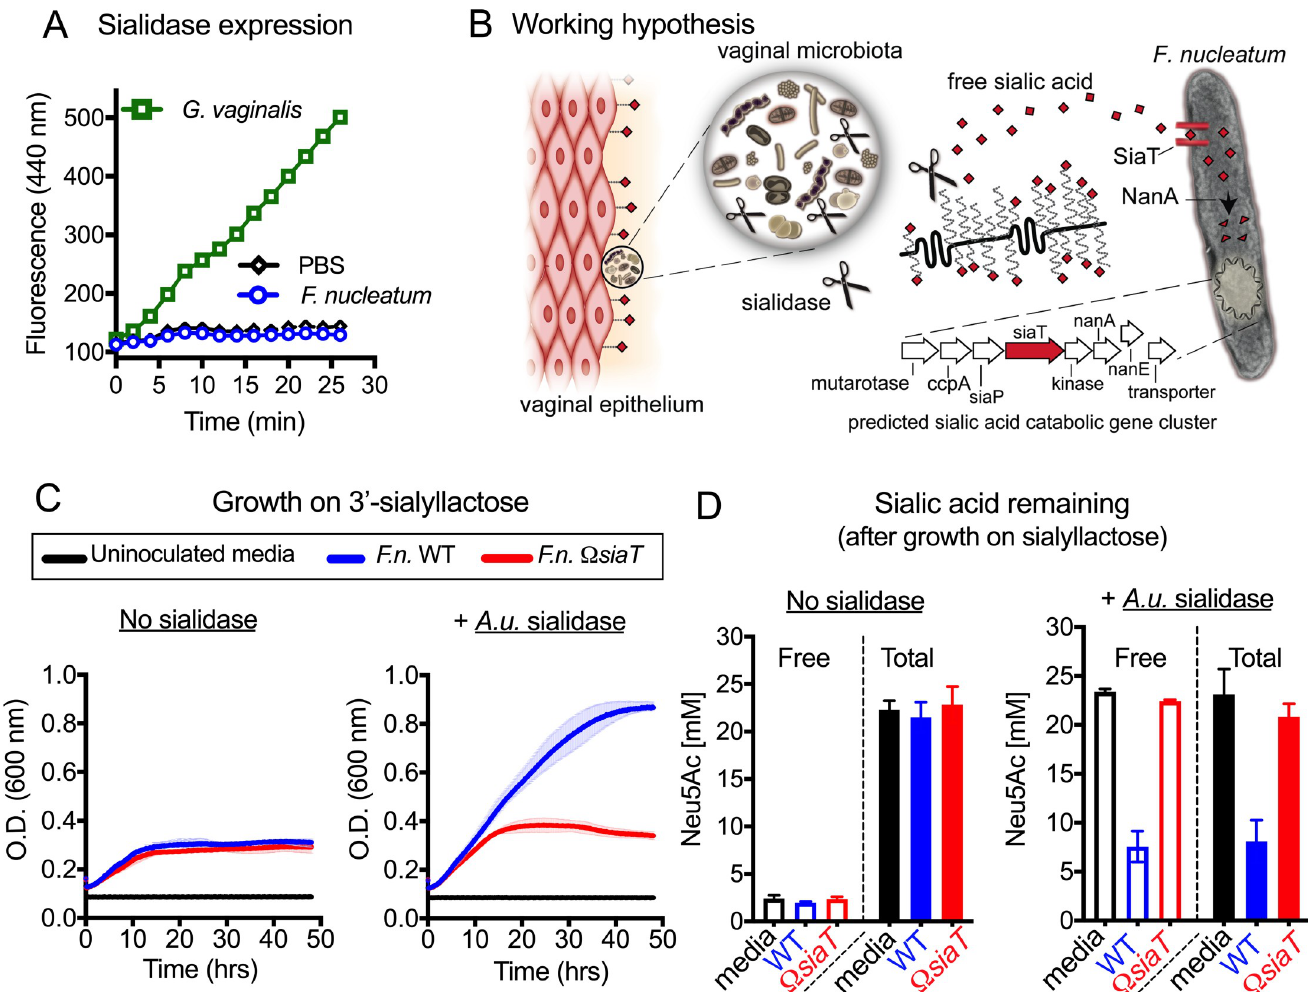
Fig 3. F . n . accesses bound sialic acid from glycan chains, but only when liberated by exogenous sialidases. (A) Analysis of cell-associated sialidase activity of anaerobically cultured G . vaginalis JCP8151B and F . n . ATCC23726 strains using fluorogenic 4MU-Neu5Ac substrate. (B) Working hypothesis: sialidase producers in the vaginal microbial community release free sialic acids (red diamonds) from host glycoconjugates, which may be accessed by F . n ., which does not produce sialidase. More information about F . n . genes shown in the predicted sialic acid catabolic gene cluster and the enzymes they encode can be found in S2 Table. (C) Growth of F . n . ATCC23726 WT and O siaT in nutrient-limited media with added 3SL, in the absence of sialidase (no sialidase) or presence of exogenous A . u . sialidase. (D) Concentrations of remaining free and total sialic acid (Neu5Ac) in nutrient-limited media (with added 3SL, from experiment shown in C) that was either uninoculated or inoculated with F . n . WT or O siaT strain (in absence and presence of A . u . sialidase). Total and free sialic acid content was measured at approximately 48 h postinoculation. Bound sialic acids are inaccessible to F . n . except in the presence of exogenous sialidase. All data shown are representative of 3 independent experiments. The underlying numerical data for this figure can be found in S1 Data. Error bars represent standard deviation from the mean. ATCC, American Type Culture Collection; A . u ., A . ureafaciens ; F . n ., F . nucleatum ; NanA, N -acetylneuraminate lyase; Neu5Ac, N -acetylneuraminic acid; OD, optical density; PBS, phosphate-buffered saline; siaT , predicted sialic acid transporter; WT, wild type; 3SL, 3 0 -sialyllactose; 4MU, 4-methylumbelliferone.